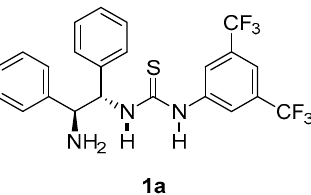
Figure 2. Catalysts based on DPEN and thiourea.